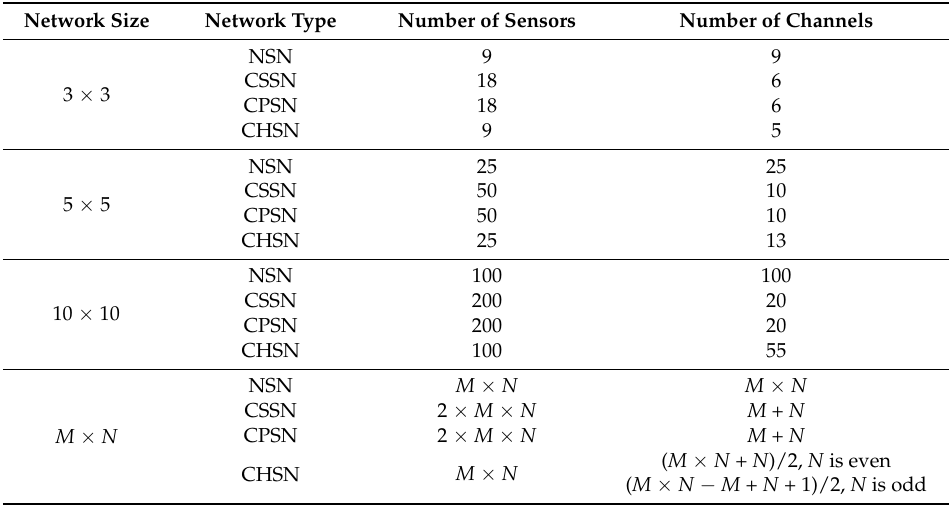
Table 2. Comparison of CSSN, CPSN, CHSN and NSN.